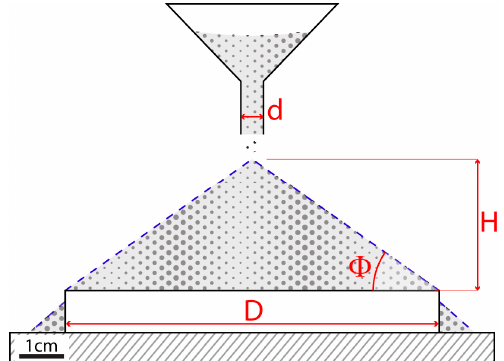
Figure 4. Schematic cartoon showing the measuring procedure of the angle of repose (modified after de Campos and Ferreira [50]).